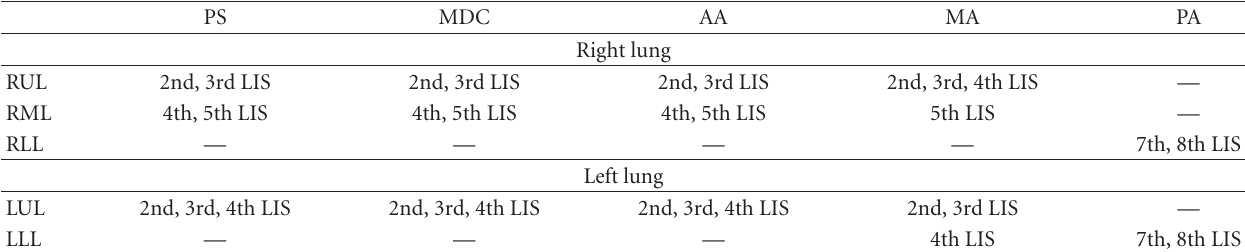
Table 1: Ultrasound scanned intercostal spaces grouped in respective pulmonary lobes.